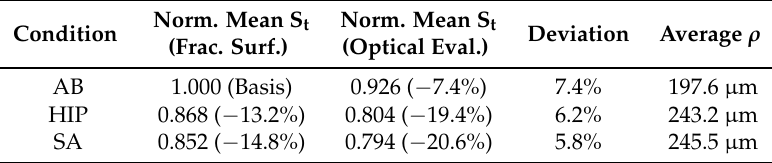
Figure 8. Surface notch valley radii measurement. Table 5. Results of the surface roughness